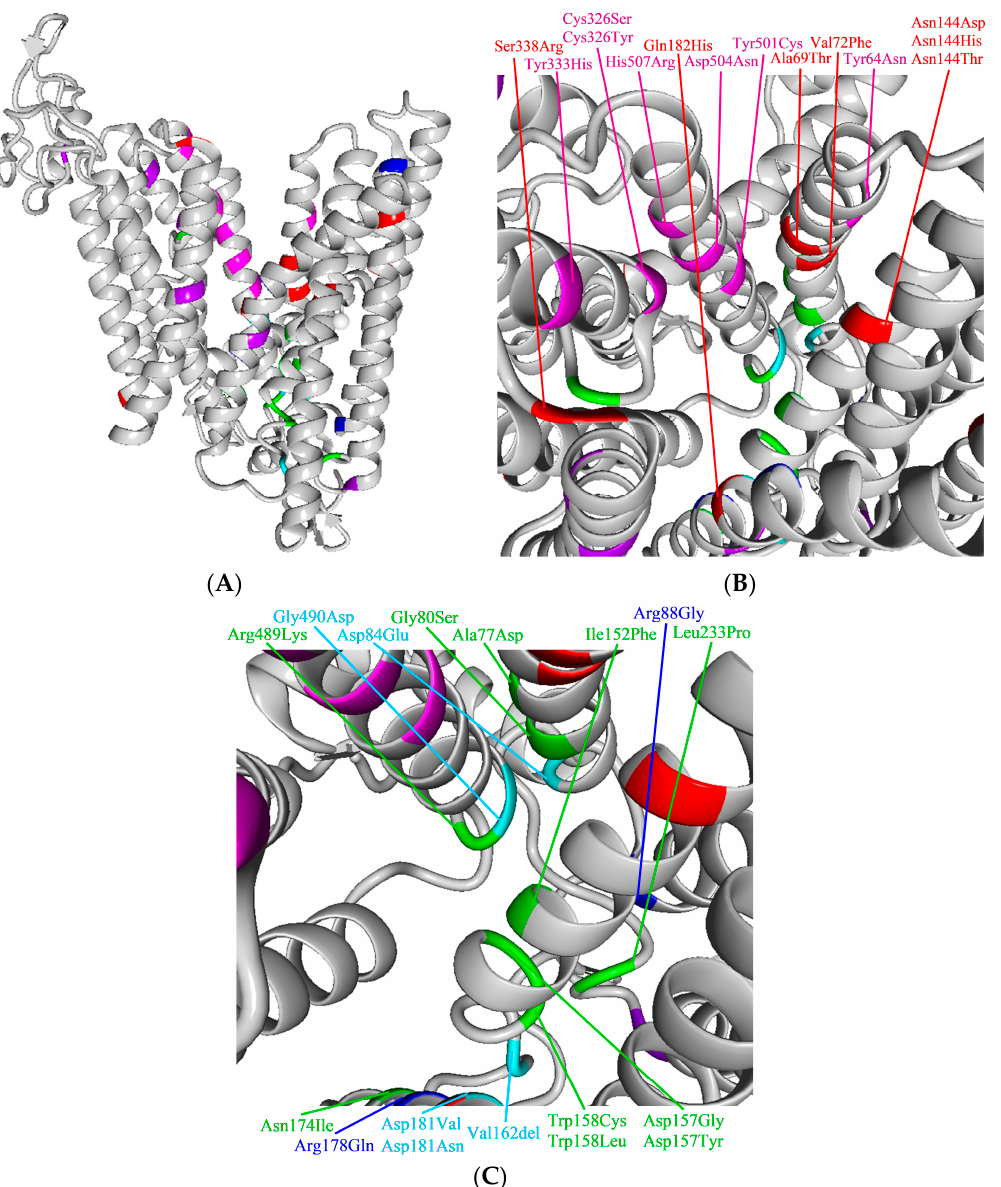
Figure 4. 3D model of ferroportin. (A) . Overview. Ferroportin facing outward position. Top: extracellular; Bottom: intracellular. ( B) . Localization of hepcidin-resistant GOF variants. View inside the “channel” from extracellular to intracellular. Six (Cys326Tyr, Cys326Ser, Tyr333His, Tyr501Cys, Asp504Asn, and His507Arg) of the seven residues of GOF hepcidin-resistant variants are located inside the channel. The Ala69, Val72, Asn144, Gln182, and Ser338 residues are also located inside the channel. However, these variants have conflicting or no data on hepcidin sensitivity. ( C) . Clustering of LOF variants at the intracellular side of ferroportin. View inside the channel from extracellular to intracellular. Red: GOF without or conflicting data about hepcidin sensitivity; Pink: GOF hepcidin-resistant variants; Purple: GOF hepcidin-sensitive or neutral variants; Green: LOF without or conflicting data about hepcidin sensitivity; Light blue: LOF hepcidin-resistant variants; Blue: LOF hepcidin-sensitive variants. We used bacterial ferroportin for the 3D model (PDB file